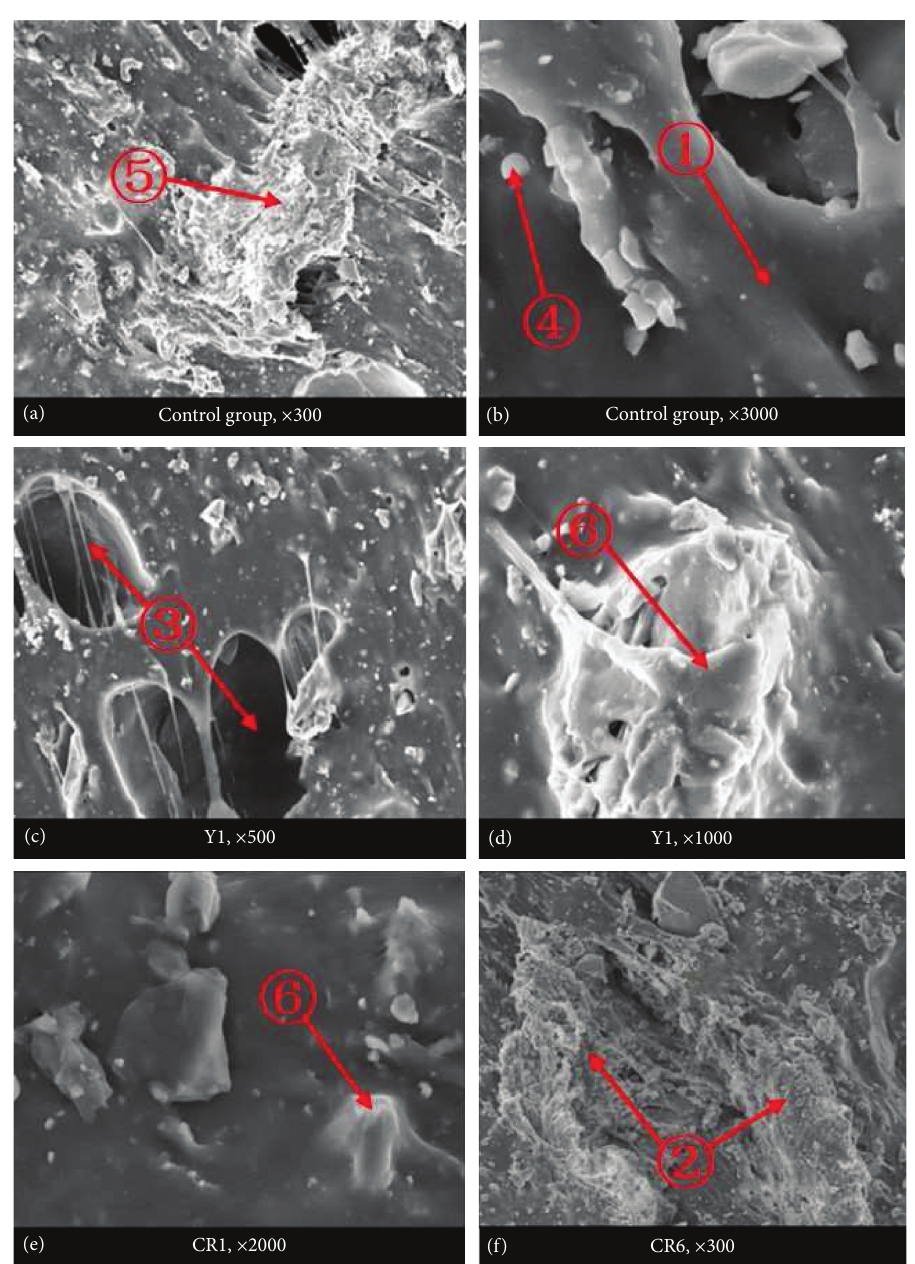
Figure 18: Typical microscopic morphology of PCC. ① Polymer film structure; ② the composite network structure; ③ pores; ④ unhydrated cement particles; ⑤ aggregates formed by fillers and cement hydration products; ⑥ agglomeration phenomenon. (a) Control group, × 300, (b) Control group, × 3000, (c) Y1, × 500, (d) Y1, × 1000, (e) CR1, × 2000, and (f) CR6, ×